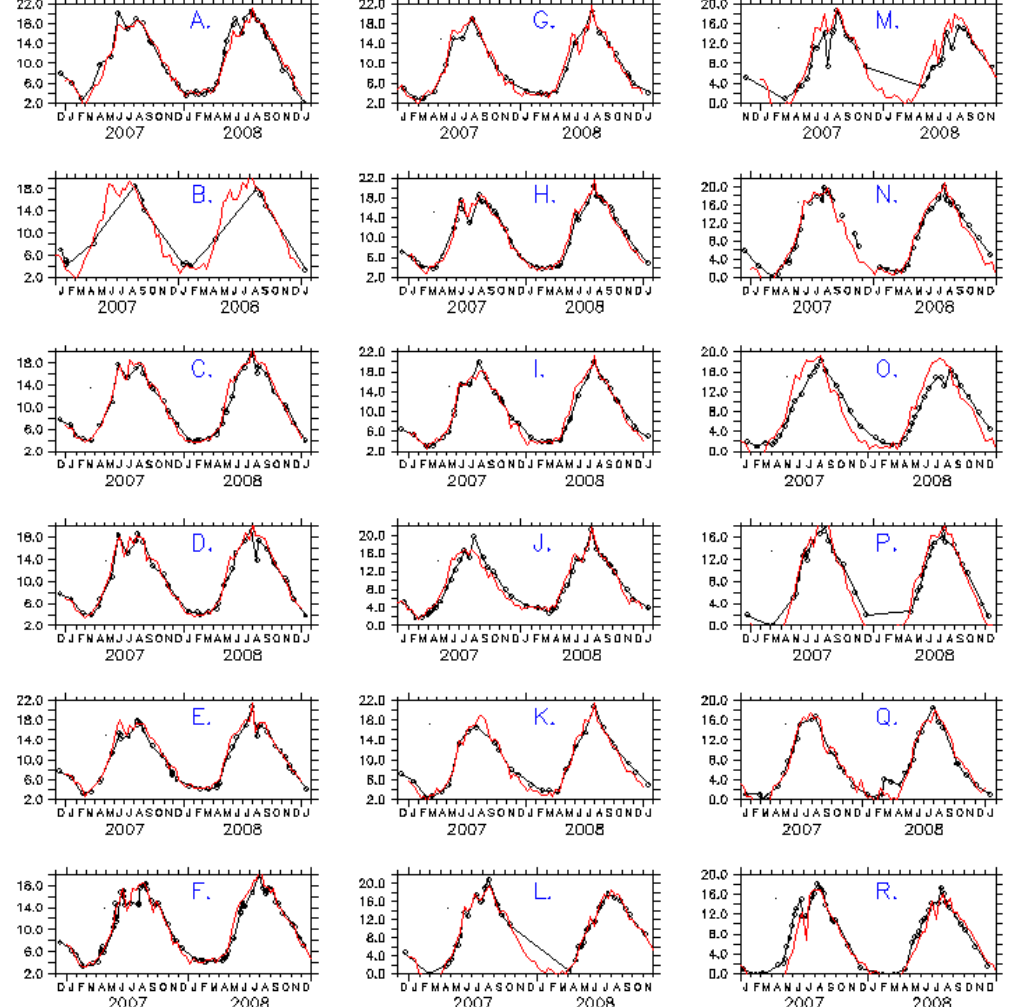
Fig. 2. Seasonal variability of temperature in surface layer. Red solid curve (black dashed cycles) for model results (observations). Unit: ◦ C. Panels (A–R) for Stations A–R (Fig. 1), respectively.